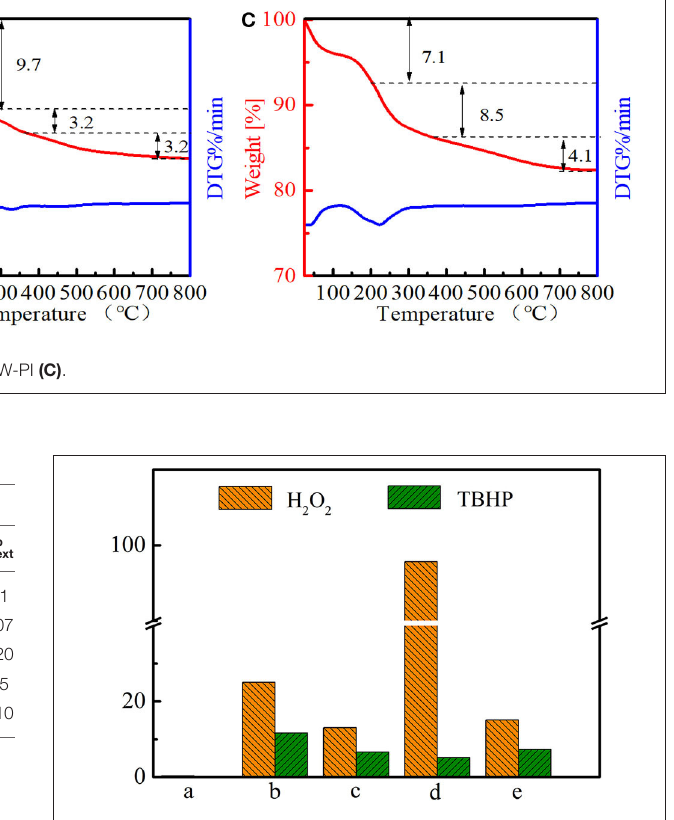
FIGURE 5 | The catalytic performance of Ti-MWW-AM (a), Ti-MWW-AT(b), Ti-MWW (c), R-Ti-MWW-PI (d), and R-Ti-MWW-PI-cal (e) in the CPE epoxidation reaction with H 2 O 2 or TBHP as an oxidant. Reaction conditions: catalyst, 50mg; cyclopentene, 10 mmol, H 2 O 2 (30 wt.%) or TBHP (70 wt.%), 10 mmol; MeCN, 10mL; temp., 333K; time,